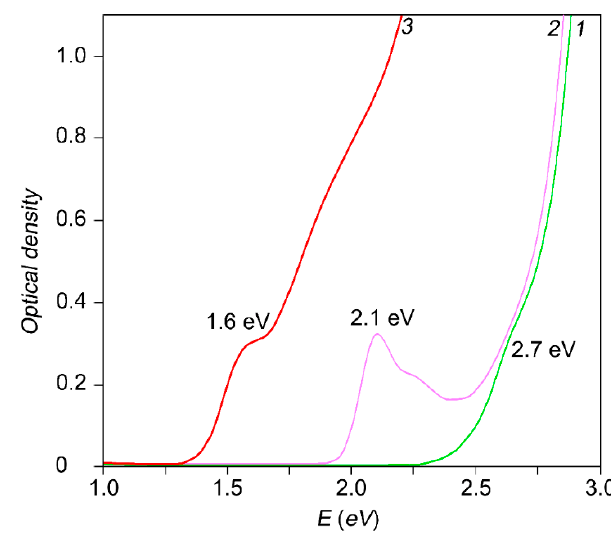
Figure 2. Optical absorbance spectra of Ag 2 S QDs colloidal solutions. The curves have characteristic features at of 1.6 eV, 2.1 eV, and 2.7 eV, for solutions with an Ag 2 S QDs average size of 3.2 nm, 2.0 nm, and 1.8 nm, respectively.